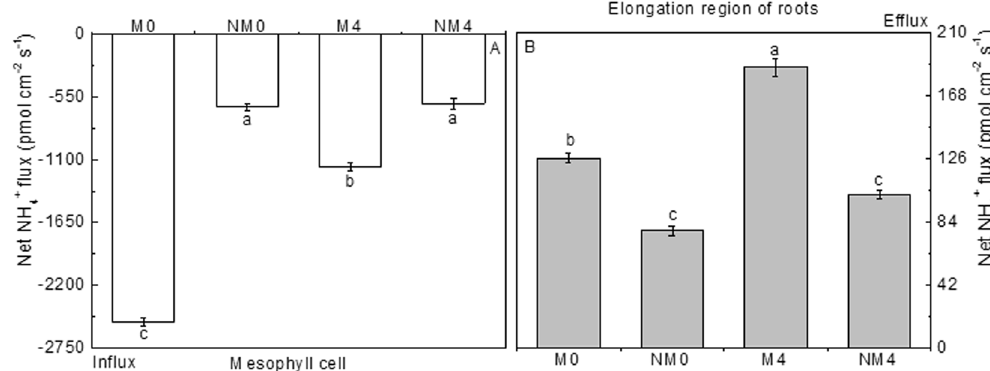
Figure 3. Changes in net NH 4 + flux in mesophyll cells ( A ) and in the elongation region ( B ) within 10 min at 10 mm from the root tips of Neva irrigated with magnetized and non-magnetized brackish water. The means ± SEs (n > 3) of the values obtained for mesophyll cells and the elongation region are shown. Values followed by different lowercase letters represent statistically significant differences at the 0.05 probability